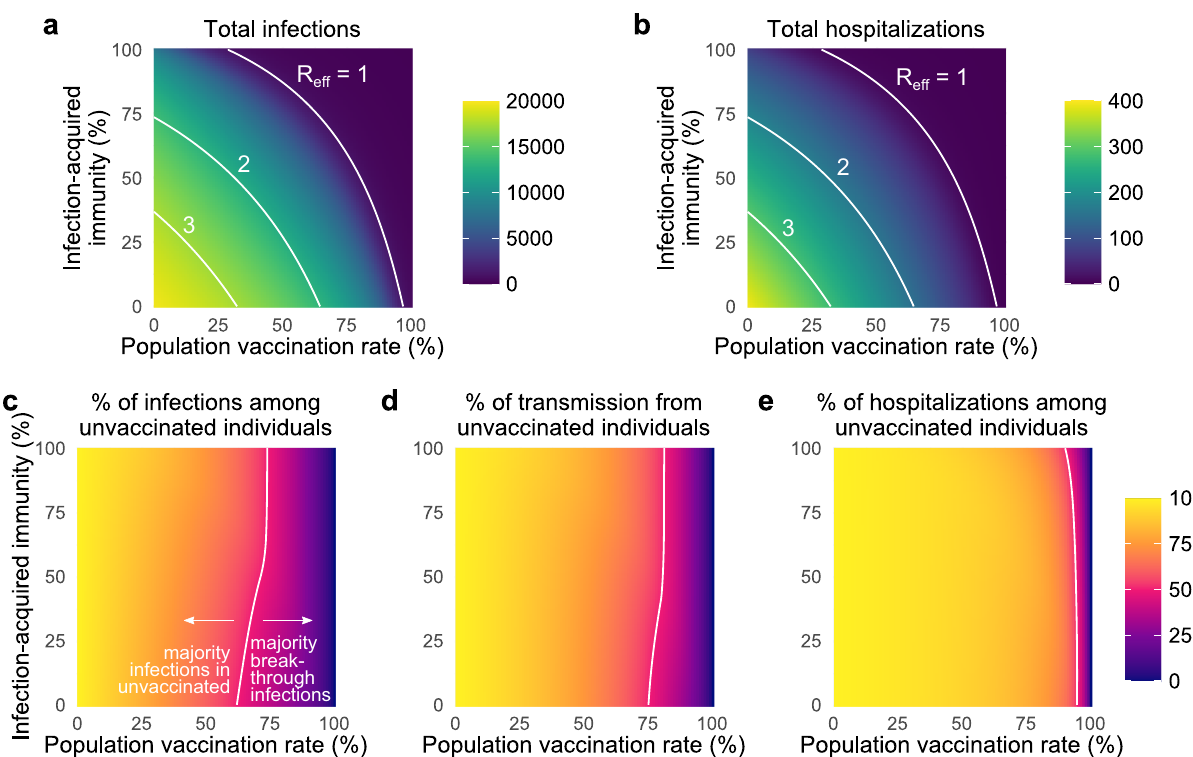
Fig. 2 Vaccination and prior infection rates affect epidemic potential, vaccine breakthroughs, and drivers of transmission. Heatmaps show a the total number of infections, b the total number of hospitalizations, c the percentage of total infections occurring in the unvaccinated population, d the percentage of total infections caused by the unvaccinated population, and e the percentage of total hospitalizations occurring in the unvaccinated population for simulated epidemics (see text). White annotation curves show ( a , b ) isoclines of the effective reproductive number R eff calculated at t = 0, and the line of parameters along which ( c ) 50% of infections were breakthroughs, d 50% of transmission was due to breakthrough infections, and e 50% of hospitalizations were breakthroughs. N = 20,000 and R NPI ¼ 4 for all plots, with baseline VE and immunity parameters vs. the delta variant (Materials 0 and Methods, Supplementary Tables 1 and 2); no testing. See Supplementary Fig. 2 for R NPI ¼ 0